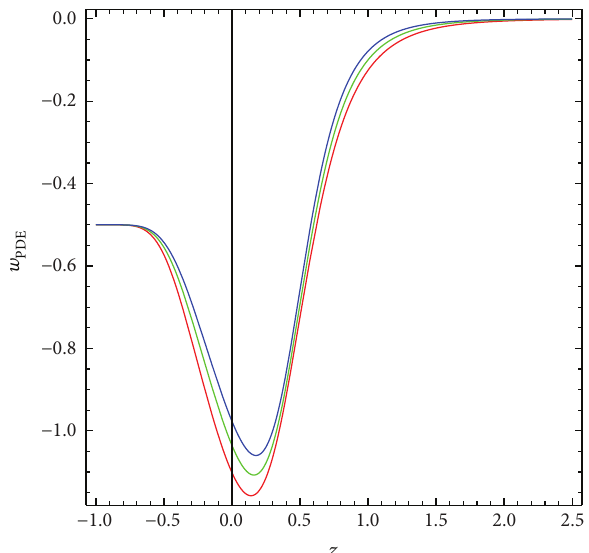
Figure 1: Plot of 𝑓(𝐺) versus 𝐺 for PDE parameter 𝑢 = 2 with 𝑚 = 2 (red), 𝑚 = 2.2 (green), and 𝑚 = 2.4 (blue).